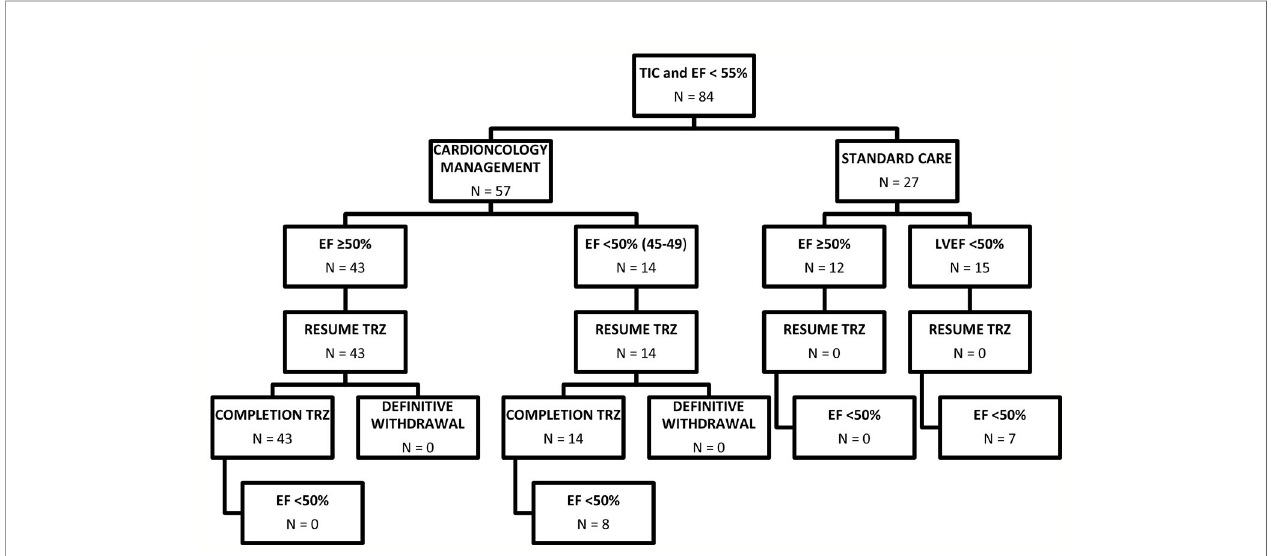
FIGURE 1 | Diagram summarizing patients included in the study. EF, Ejection fraction; TIC; Trastuzumab induced cardiotoxicity; TRZ, Trastuzumab.